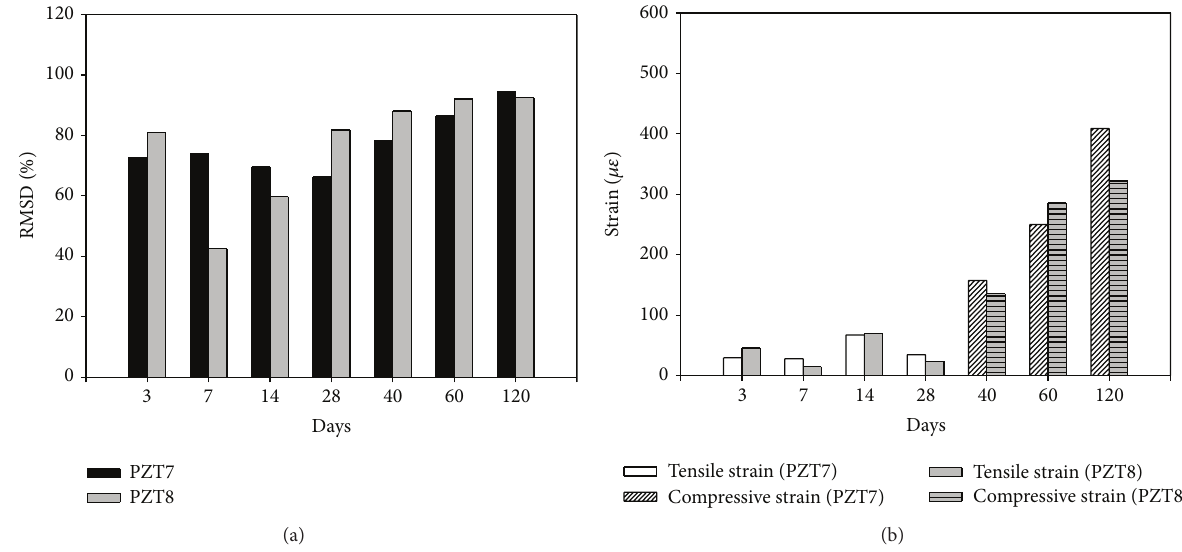
Figure 22: Comparison of PZT7 and PZT8: (a) RMSD value and (b) strain of concrete around EMI sensors.